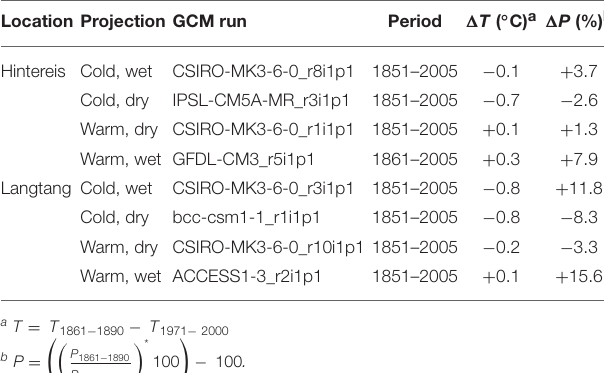
TABLE 1 | Selected ensemble of historical GCM runs for the Hintereisferner and Langtang glaciers with simulated basin-averaged changes in mean temperature and precipitation in 1861–1890 relative to